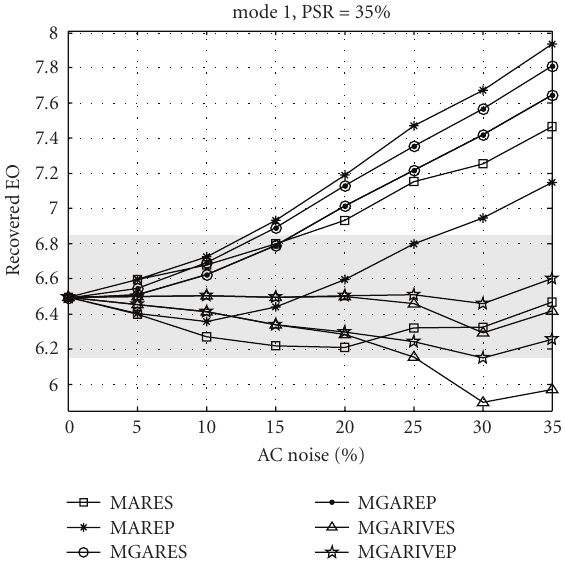
Figure 9: Test 2: 95% confidence bands for exact solution methods, mode